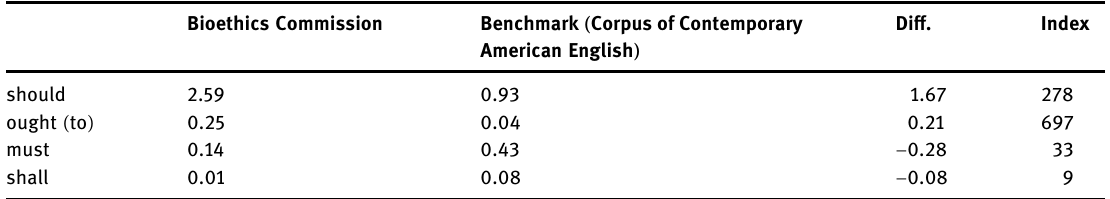
Table 4: Word list extract: frequency of “ should, ” “ ought ( to ) , ” “ shall, ” and “ must ” use per 1,000 words ( normalised, n = 1,000 ) by commission members, compared to benchmark corpus